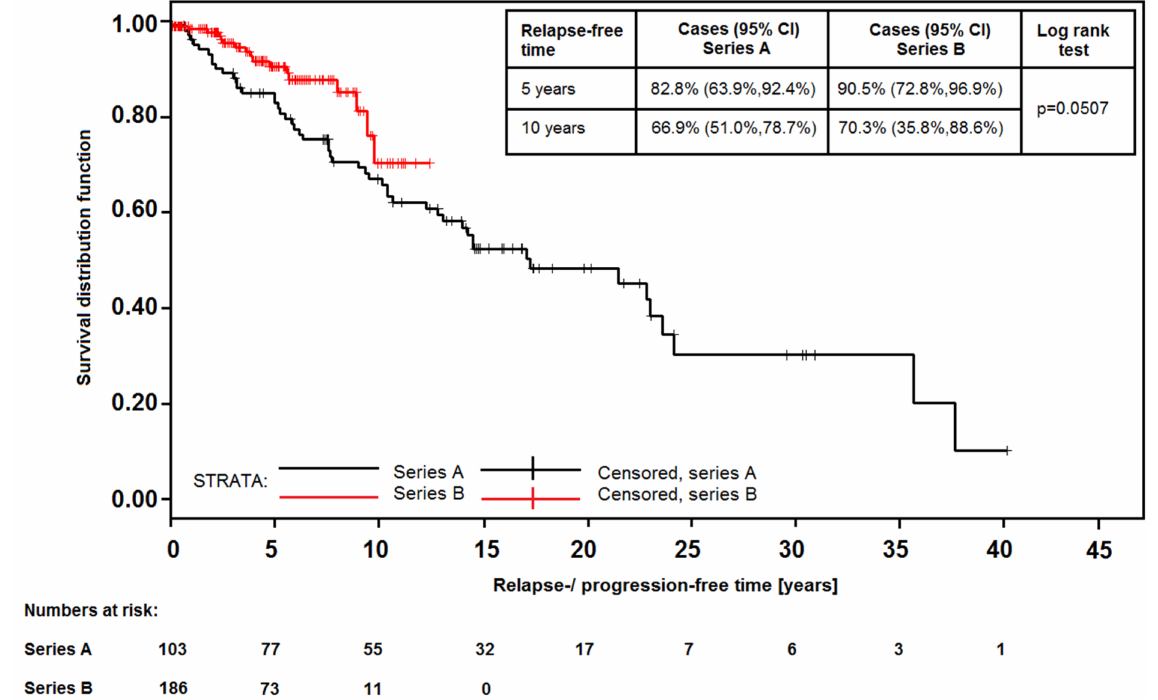
Figure 1: Relapse-free time after the start of specific treatment for AE (either BMZ treatment or first liver surgery; CI=Hall-Wellner confidence